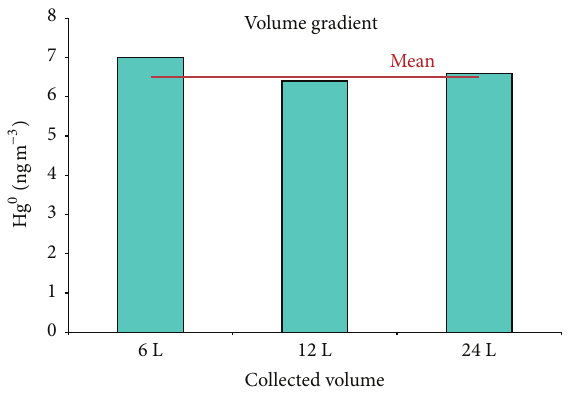
Figure 8: Concentrations of Hg 0 as a function of sample